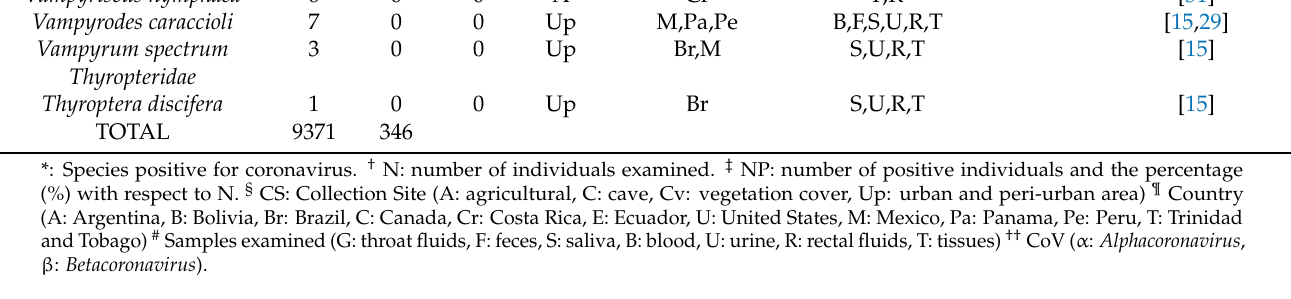
Table 2. Bat species in which experimental infection with coronavirus has been carried out in the